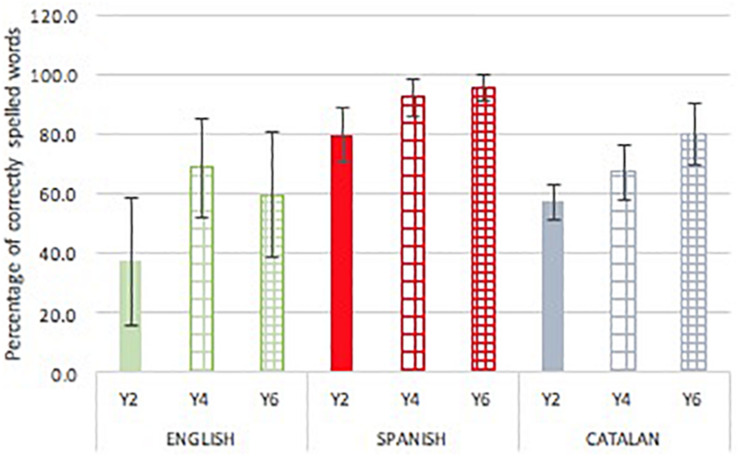
Mean (SD) percentage of correctly spelled words by language and school grade.